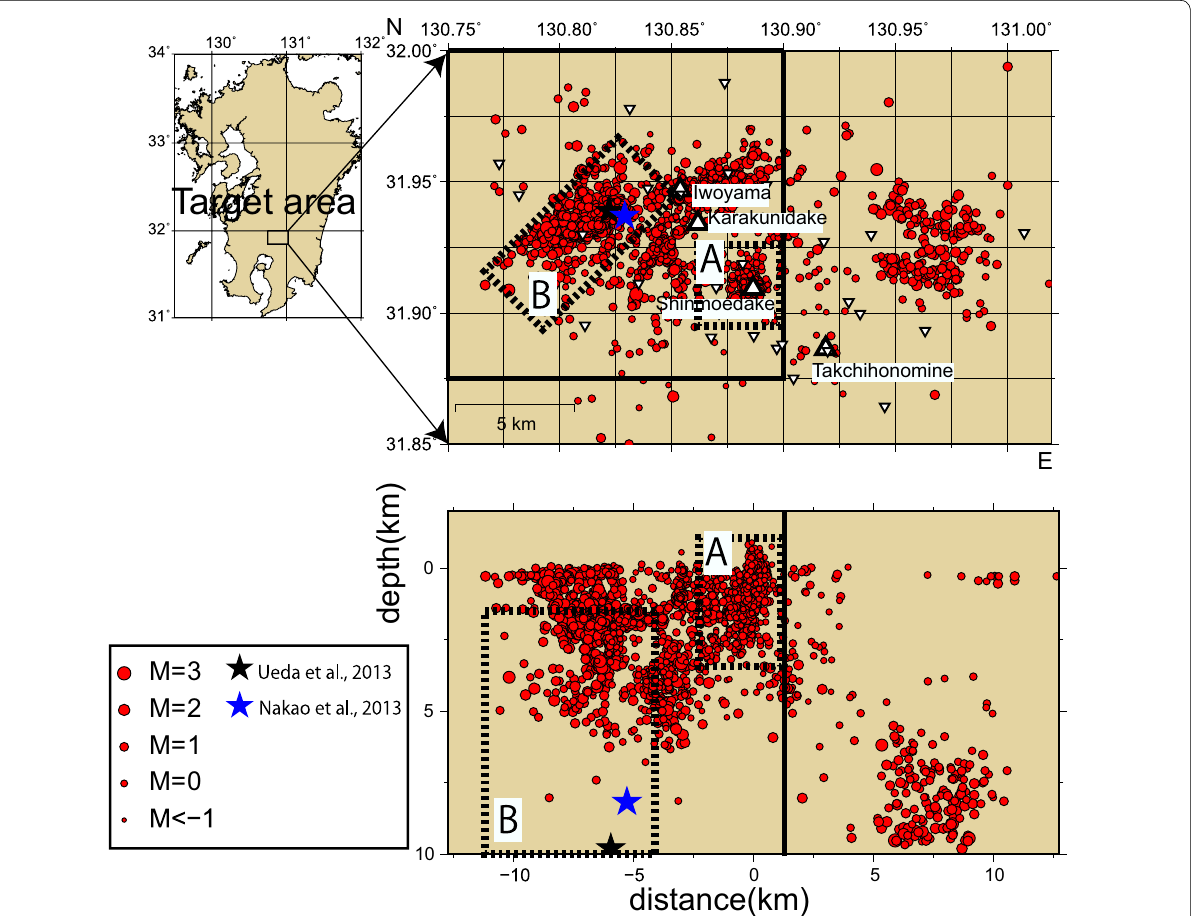
Fig. 1 Distribution of hypocenters with magnitudes greater than M = − 0.5 in the original catalog, January 1, 2007, to October 26, 2017. Triangles show the locations of Shinmoe-dake, Karakuni-dake, Iwo-yama, and Takachihonomine volcanoes of the Kirishima volcano group. The black square and two dotted rectangles show regions where spatial and temporal distributions of b -value were calculated, respectively. Inverted triangles show the locations of observation stations. Stars show the locations of the pressure sources related to the 2011 Shinmoe-dake eruption, as estimated by Nakao et al. (2013) and Ueda et al. (2013). The lower plot is a west–east cross section. The left inset shows the geographic location of Shinmoe-dake volcano, Kyushu,